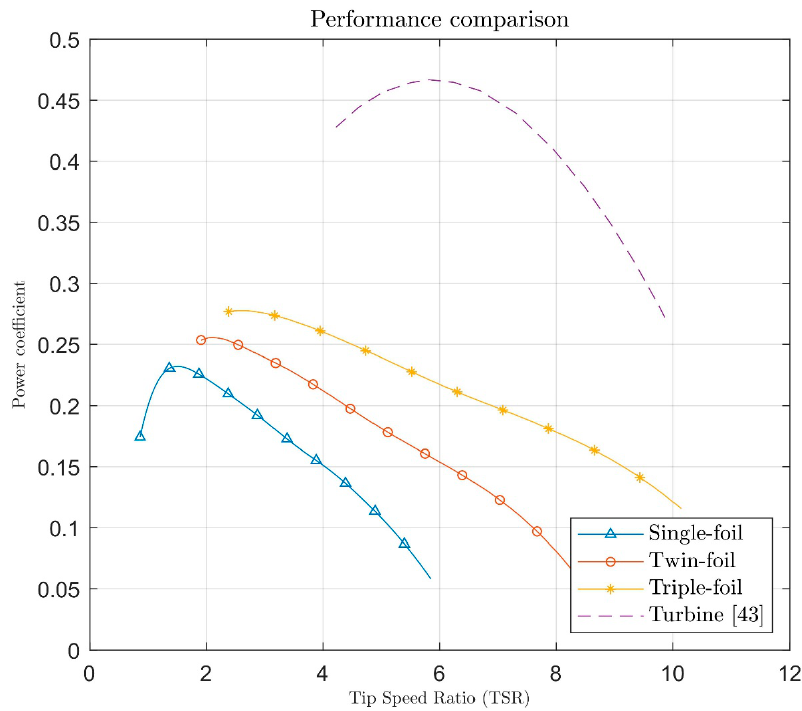
1.8 S c = . The contours show f